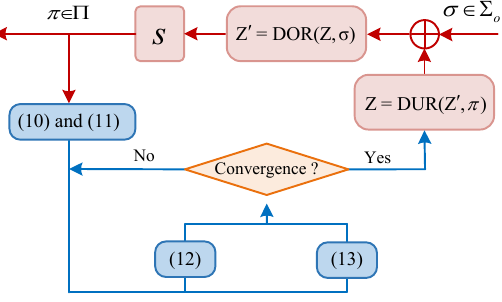
Figure 5. Online state estimation under communication